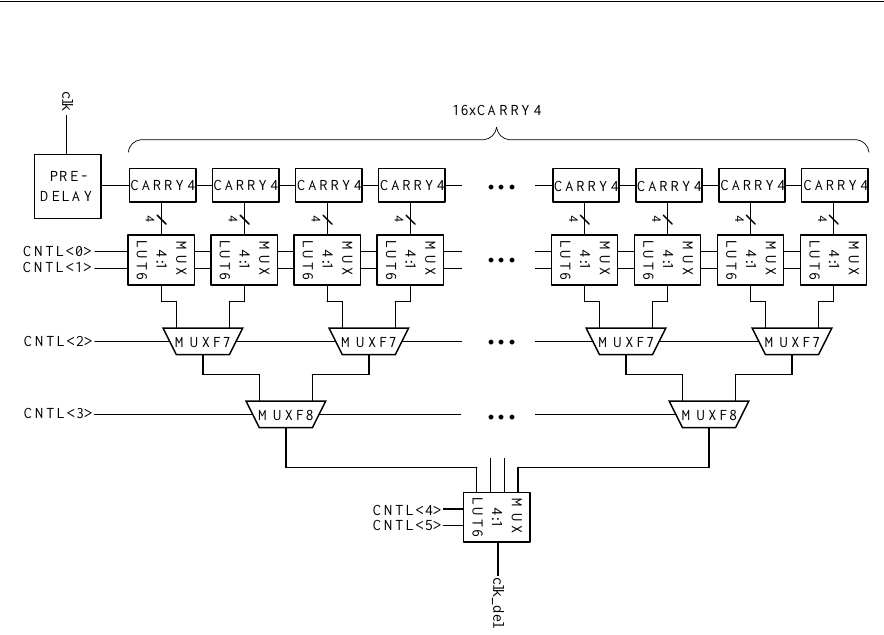
Figure 4: Architecture of the fully digital Variable Delay Line